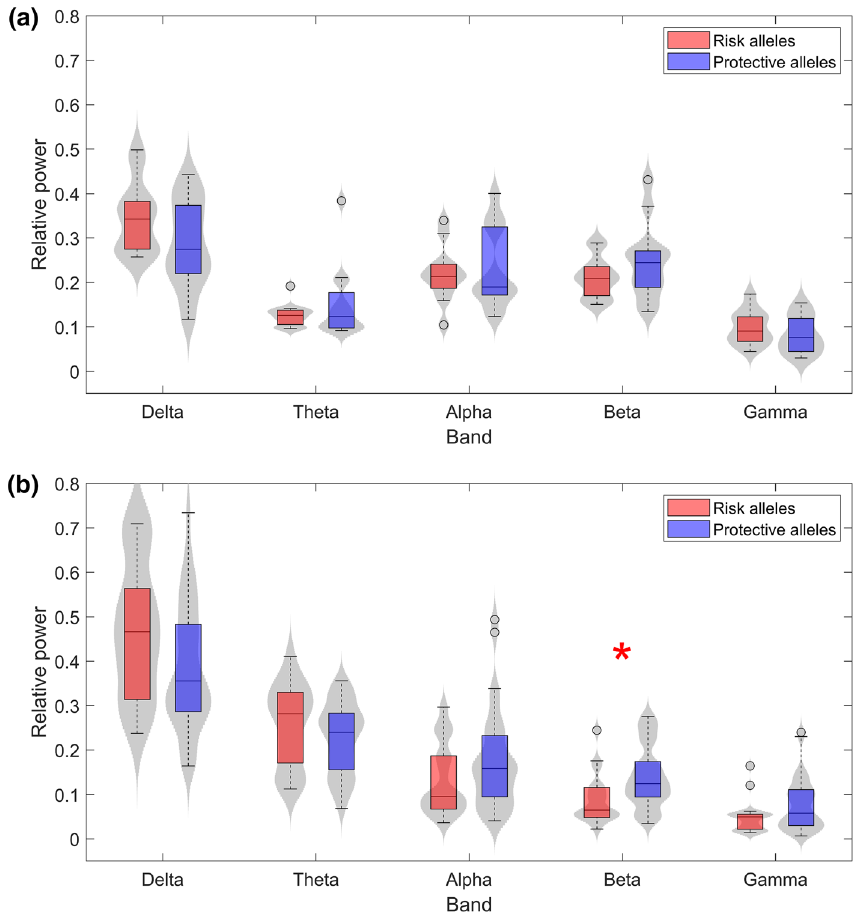
Figure 1. Grand-averaged RP values across ROIs for ( a ) controls and ( b ) AD patients in each frequency band. Subjects with risk alleles for both PICALM and CLU are represented in red, whereas subjects with both protective alleles are displayed in blue. Statistically significant differences ( p -value < 0.05, Mann–Whitney U -test) are highlighted with a red